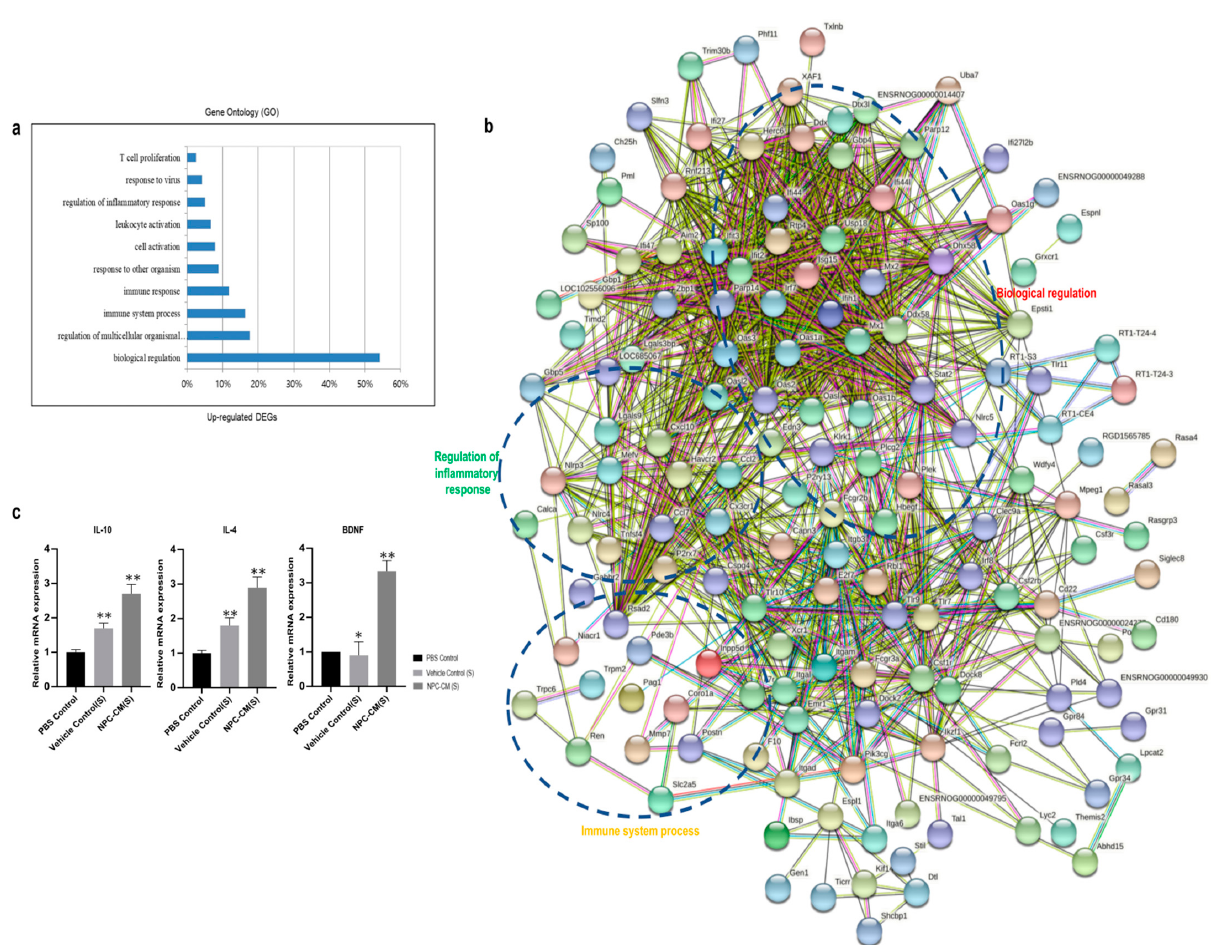
Figure 6. RNAseq transcriptome network of the ischemic brain at day 3 after pMCAO in NPC- CM(S)-treated rats vs. Vehicle control(S)-treated rats. ( a ) Gene ontology enrichment analysis of the NPC-CM-treated group at day 3 after pMCAO. Biological processes that showed the most significant p -values in gene ontology analysis are shown. ( b ) Functional network for differentially expressed genes that were associated with the immune system and neuroprotective processes at day 3 after pMCAO. ( c ) Expression levels of upregulated genes in the brain in the NPC-CM(S) assessed by reverse transcription–quantitative polymerase chain reaction; n = 3 in each group. * p < 0.05, ** p < 0.01. IL-10: interleukin-10; IL-4; interleukin-4; BDNF: brain-derived neurotrophic factor.